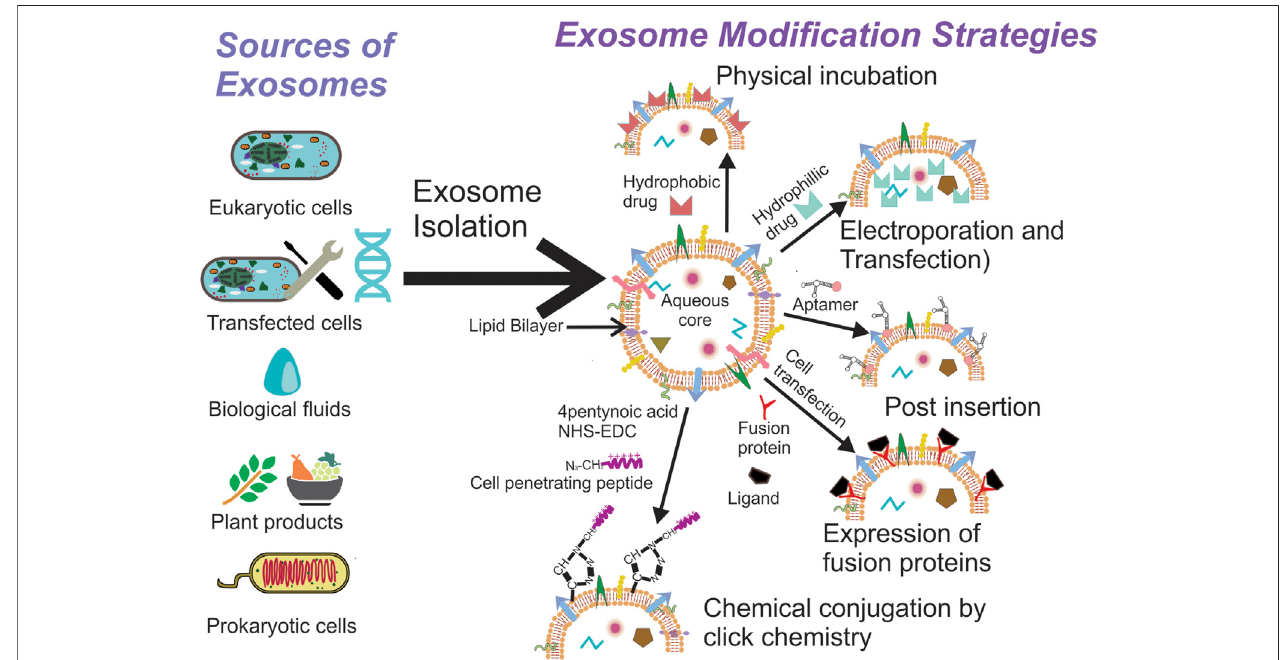
FIGURE 1 | Exosomes can be isolated from a variety of sources, the selection of which depends on the intended application. Once isolated they can used directly for disease therapy or can be modi fi ed further to suit the intended application.